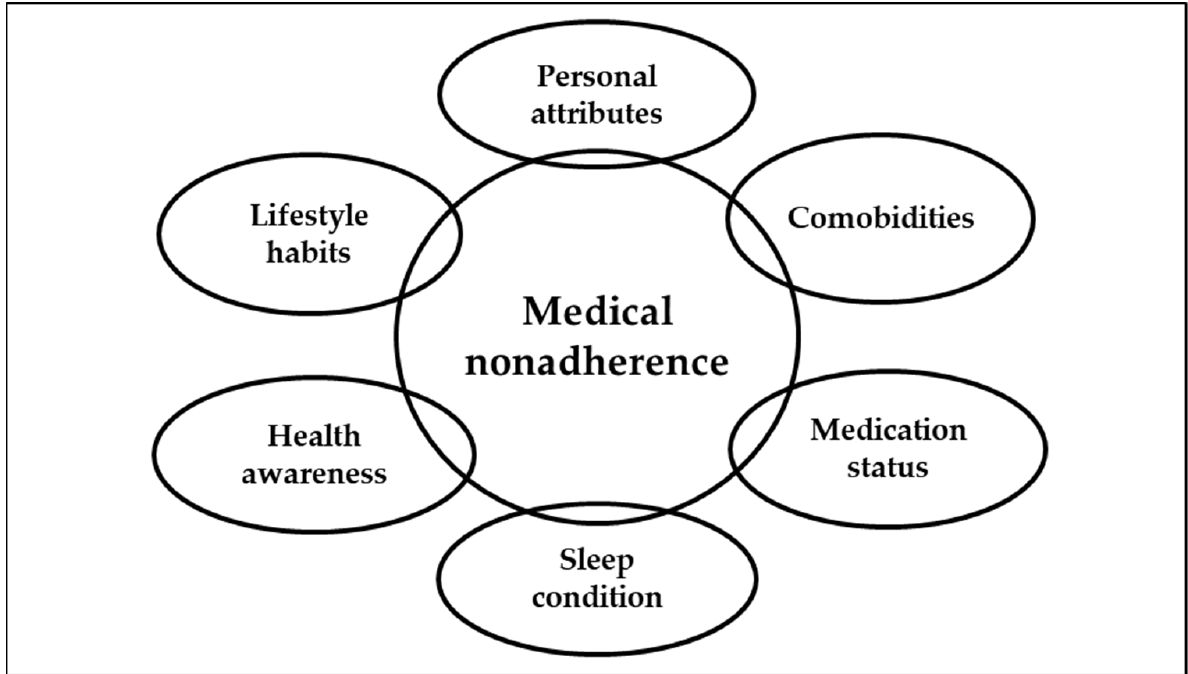
Figure 1. The considered factors associated with medical nonadherence.